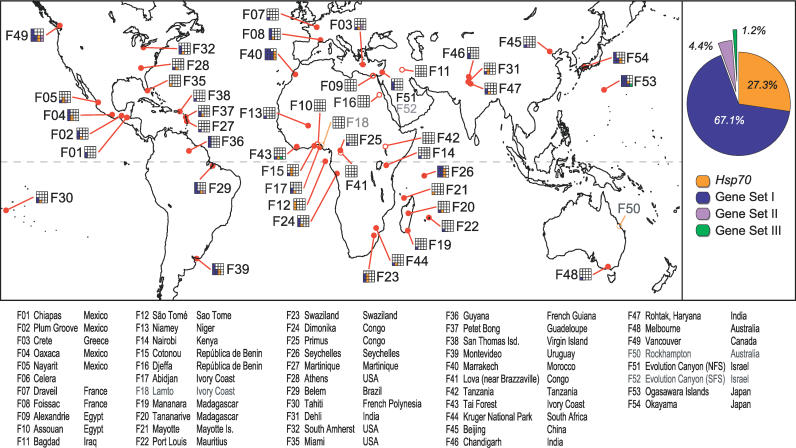
Geographic Origins of D. melanogaster Populations Screened in This StudyScreens revealed zero to 14 P elements per population (indicated by the number of squares), distinctive by insertion location, in the proximal promoter regions of genes examined (Table 1). Colors of squares correspond to gene set (see Introduction). Inset: Percentages of distinctive P elements discovered in Hsp70 genes and each of the three gene sets screened. A total of 161 P element insertions (the ten P elements in the coding sequence and the five non–P element insertions are not included in the figure). These tallies potentially under-report the actual number of P elements; see Results. F06 (Celera) is the strain whose genome has been sequenced [25] and is the reference strain for the present study. Populations F18, F50, and F52 (in light gray text) were removed from the analysis after screens failed for multiple genes and primer sets.